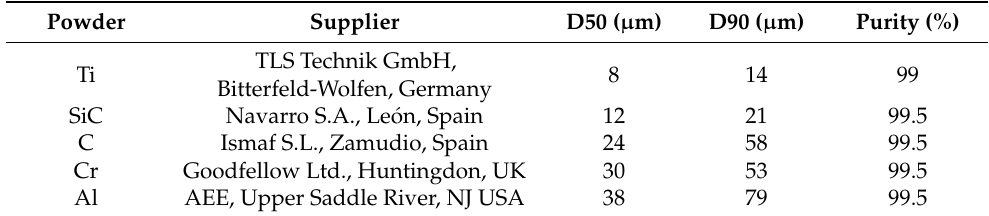
Table 1. A list and the characteristics of commercially available powders for the synthesis of Ti 3 SiC 2 and Cr 2 AlC MAX